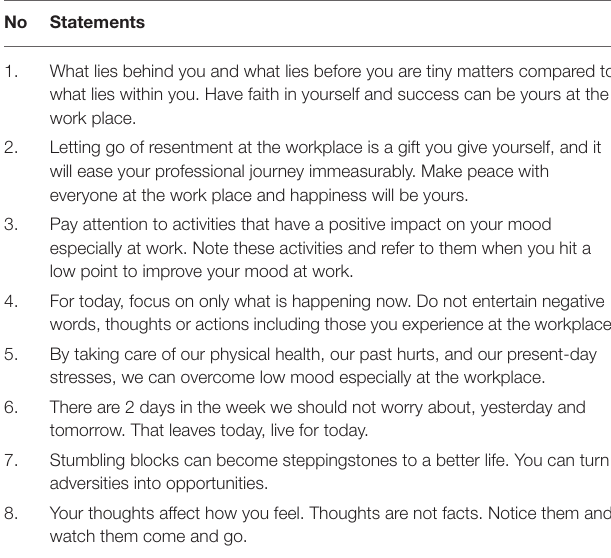
TABLE 2 | Background characteristics of employees in the pre- and post-intervention